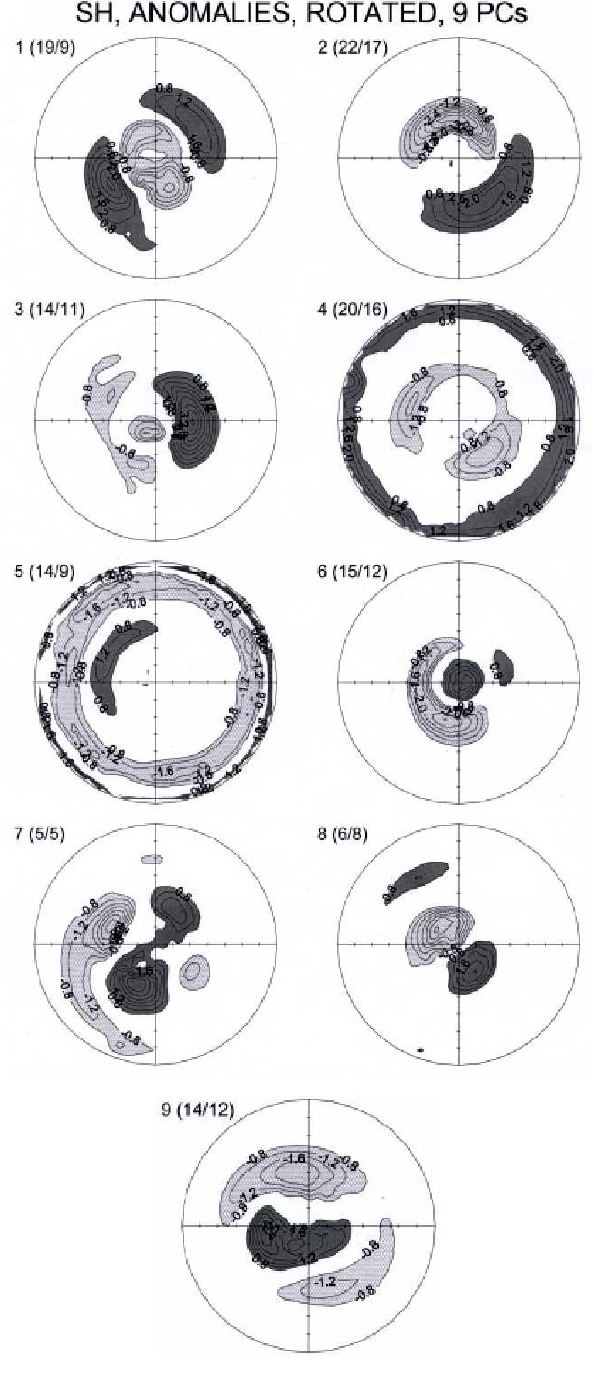
Fig. 8. Same as in Fig. 7 except for SH.